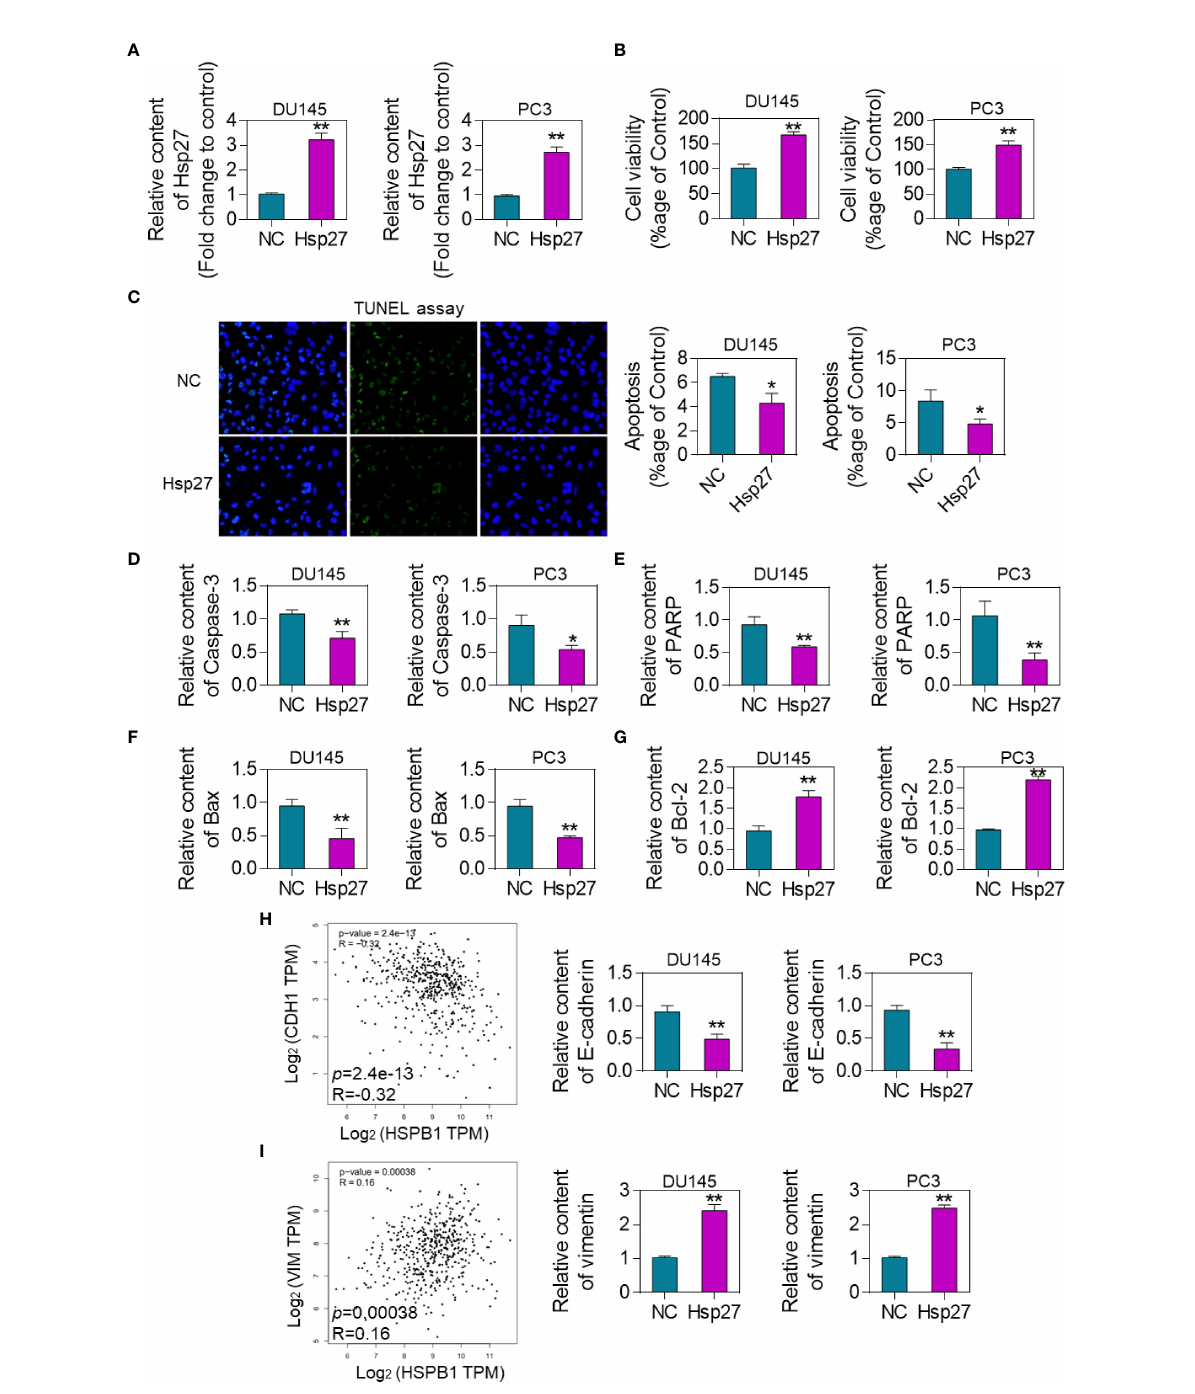
FIGURE 3 EffectsofHsp27overexpressiononDU145andPC-3cellsurvivalandapoptosis. (A) qRT-PCRanalysisofHsp27levelsinDU145andPC-3cellsstably transfectedwithemptyvector(DU145andPC-3Mock)orhumanHsp27(DU145andPC-3Hsp27). (B) MTTassaytoquantifythecellviabilityofDU145and PC-3cellsoverexpressingHsp27andMockgroups. (C)